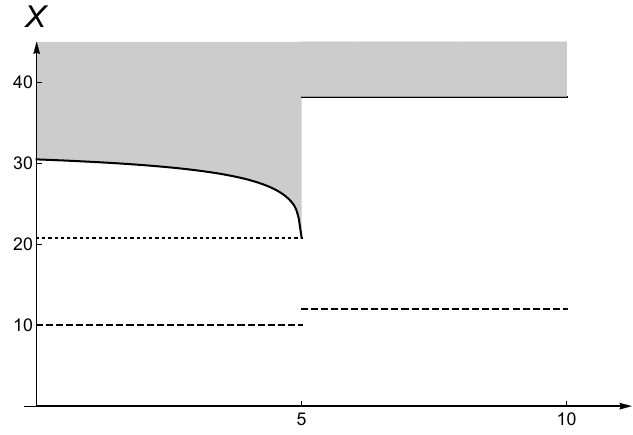
Figure 1. This figure illustrates the optimal investment boundary (solid) b ( t ) = b 1 ( t ) I ( t ≤ T ) + b 2 I ( t > T ) . The dashed line represent the investment cost, the dotted line shows x ∗ . The parameter set is r = δ = 0.03, σ = 0.3, K 1 = 10, K 2 = 12. We assume that the jump occurs at T = 5 years. For this set of parameters, b 2 = 38.23 and x ∗ = 20.81. Table 1. This table compares the integral equation (IE) method to the binomial (B) tree approach for various sets of parameter values. The IE method was computed using 200, 500 and 1000 time steps. The binomial tree method was compute using 200 time steps. The true value is based on the binomial tree method with 20,000